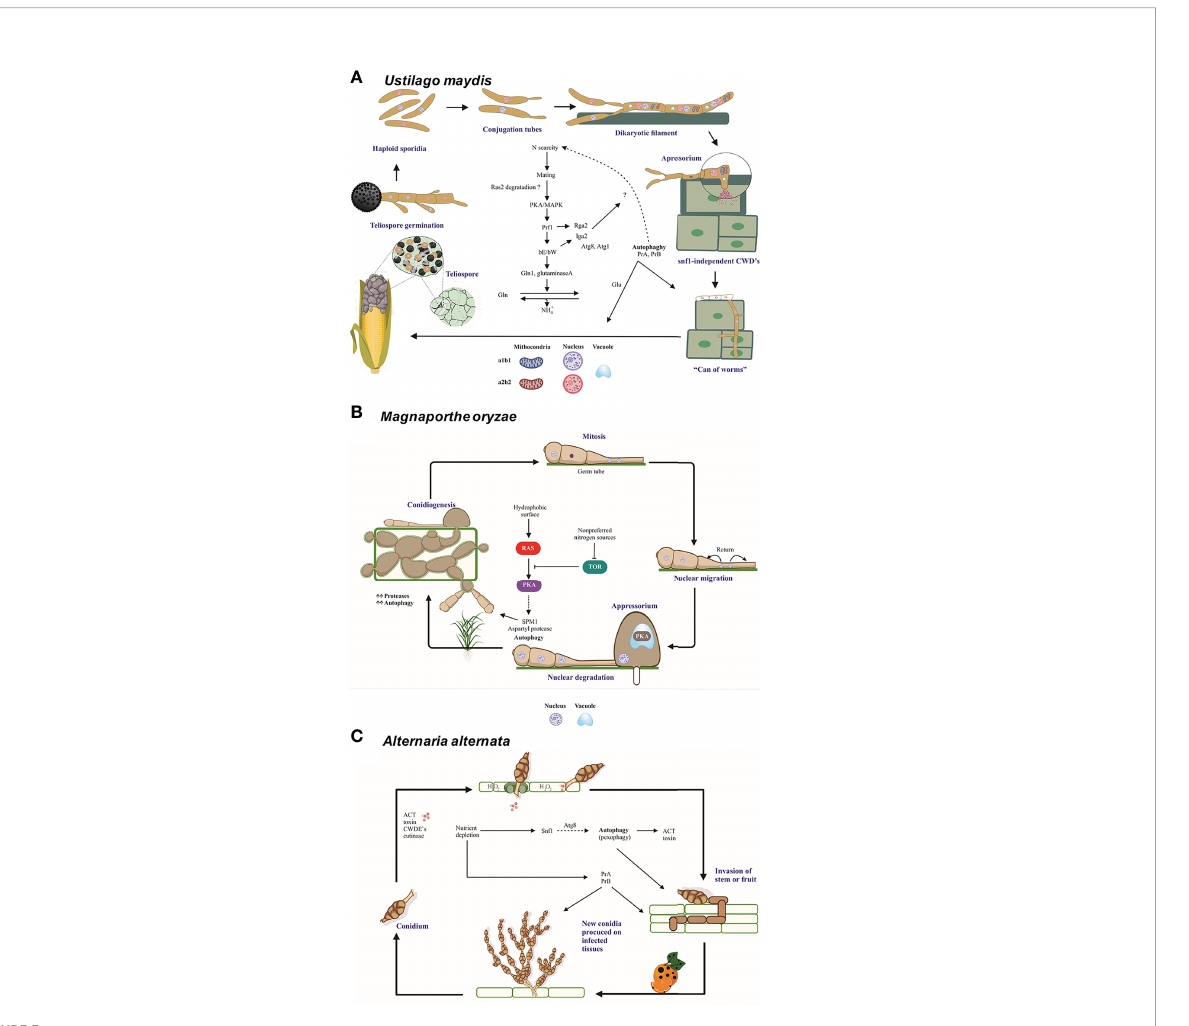
FIGURE 3 The role of autophagy and vacuolar proteases PrA and PrB in the pathosystem of U. maydis , M. oryzae , and A alternata. (A) In the course of an infection by U. maydis , nitrogen scarcity promotes fi lamentation of haploid sporidia mediated by the bE and bW genes (in an independent and nonredundant manner) and the Ump2 transporter, probably preparing the cells for mating (Wallen et al., 2021). After the mating of two compatible basidiospores, Rbf1 and bE/bW induce cell cycle arrest and dikaryotic fi laments extend apically over the host tissue. Vacuolated areas separated from empty sections by septa are generated during fi lament extension. Subsequently, non-melanized appressoria develop and penetrate the plant cells by means of CWDE ’ s (Nadal et al., 2010). During this early stage, autophagy-related genes and vacuolar proteases